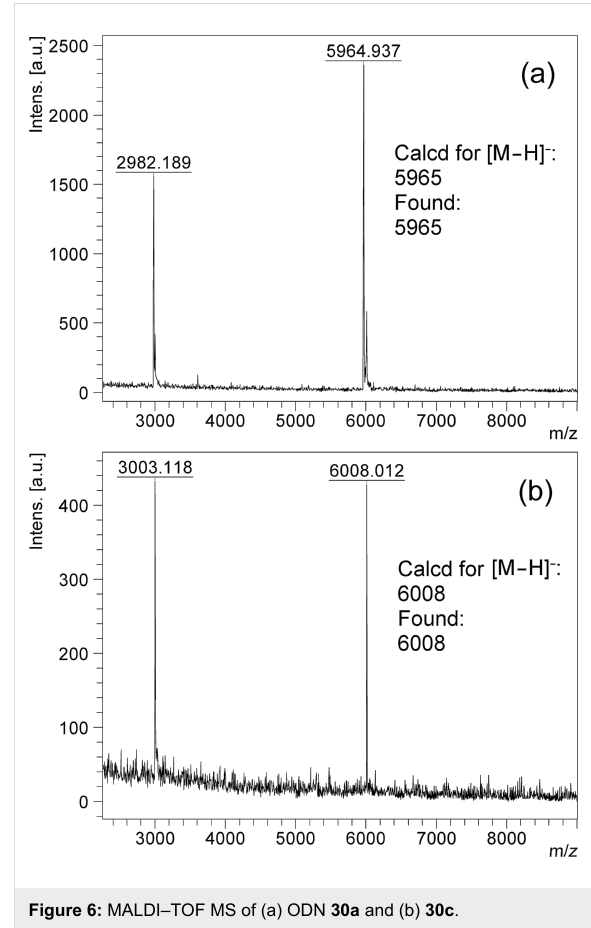
under standard conditions using acetic anhydride for capping and without tagging the 5'-end of ODNs. RP HPLC analyses showed that the peaks of the desired ODNs and branched se- which made HPLC purification of the products difficult.